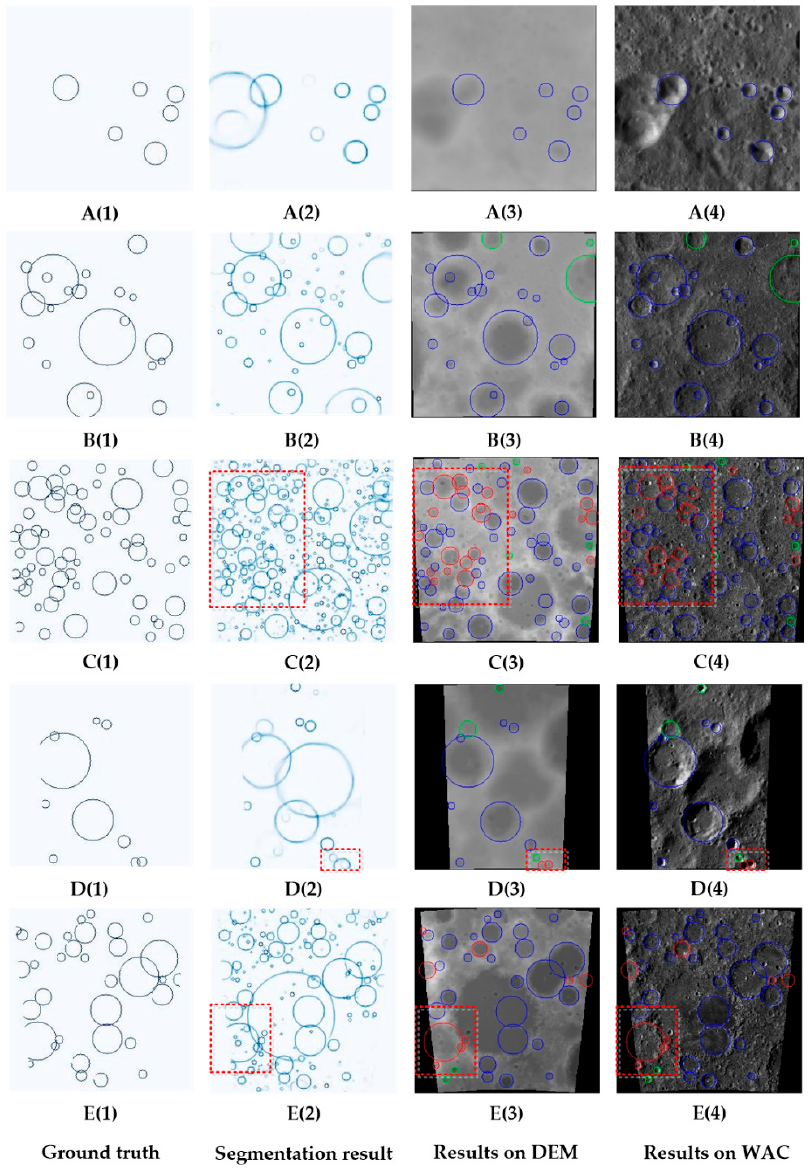
Figure 6. Some representative sample patches of the moon. ( A ( 1 )– E ( 1 )) ground-truth labels from the raw images; ( A ( 2 )– E ( 2 )) segmentation results from the Dual-Path; ( A ( 3 )– E ( 3 )) detection results of the Dual-Path on DEM after template matching; ( A ( 4 )– E ( 4 )) detection results of the Dual-Path on WAC after template matching. Blue circles represent correctly recognized craters that were successfully matched to the ground truth. Green circles denote new craters, while red circles represent unrecognized